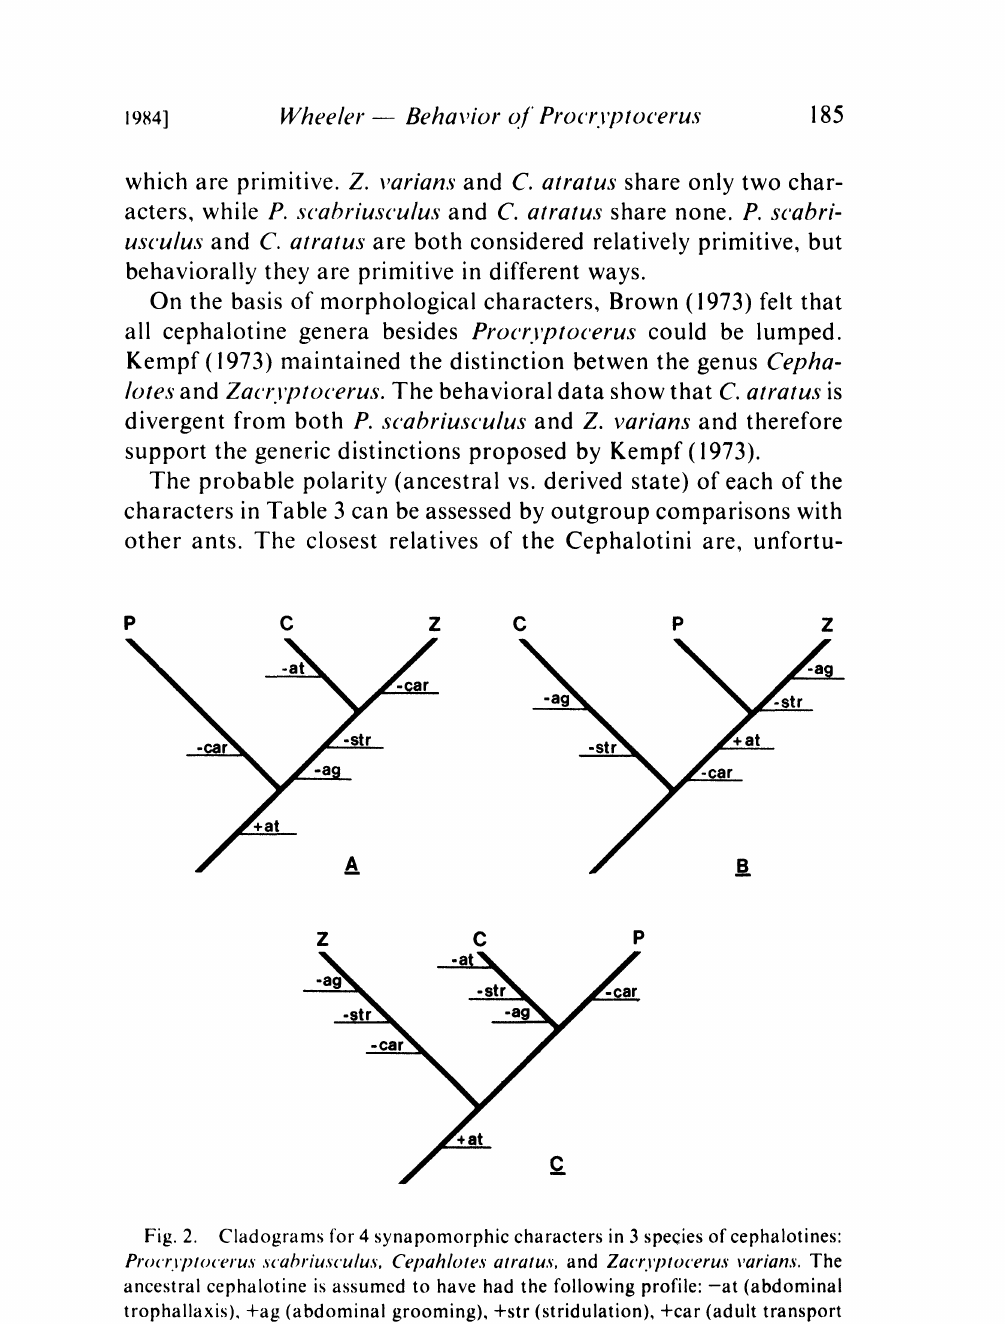
Fig. 2. Cladograms for 4 synapomorphic characters in 3 species of cephalotines: Proct:vptocerus scahriusculus, Cepahlotes atratus, and Zacryptocerus varians. The ancestral cephalotine is assumed to have had the following profile:-at (abdominal trophallaxis), +ag (abdominal grooming), +str (stridulation), +car (adult transport =carrying